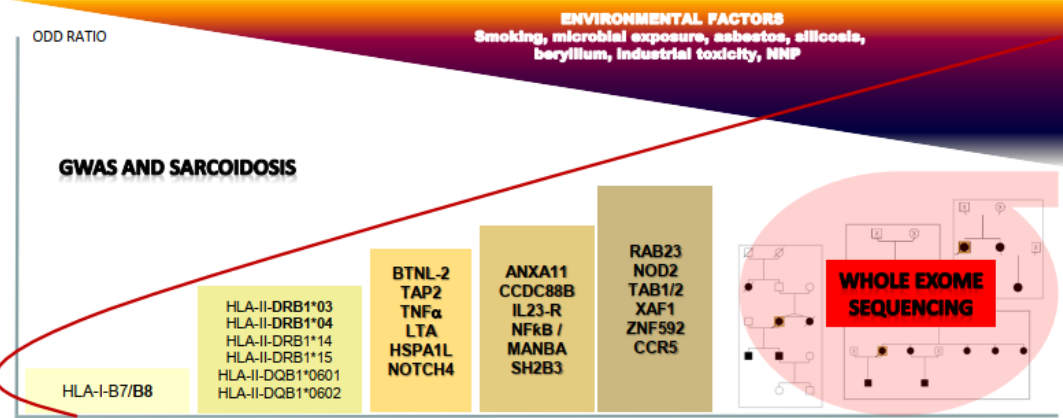
Figure 1. A representation of genes identified by genome wide association (GWAS) studies in sarcoidosis and the cumulative risk induced by the accumulation of variants closely associated with the negative impact of environmental factors. All the gene names are detailed in the text. The red line represents only a theoretical representation of the progression of the odds ratio to sarcoidosis when a patient accumulates polymorphisms in the different groups of genes. The knowledge provided by GWAS is complementary to the data from whole exome sequencing in families predisposed to sarcoidosis. NNP, nanoparticle.